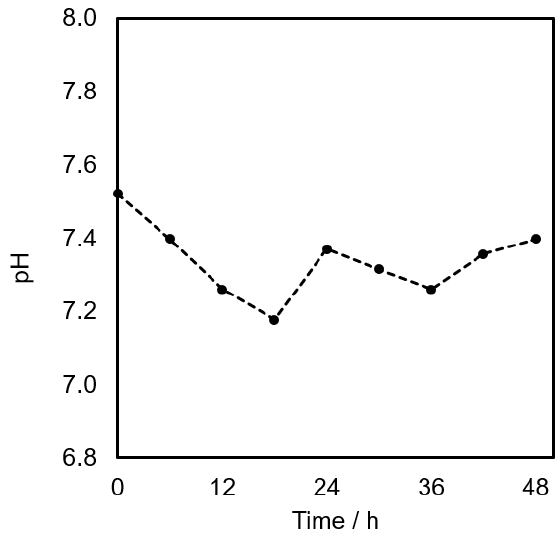
Figure 12. pH changes during L929 cell incubation in the developed bioreactor.